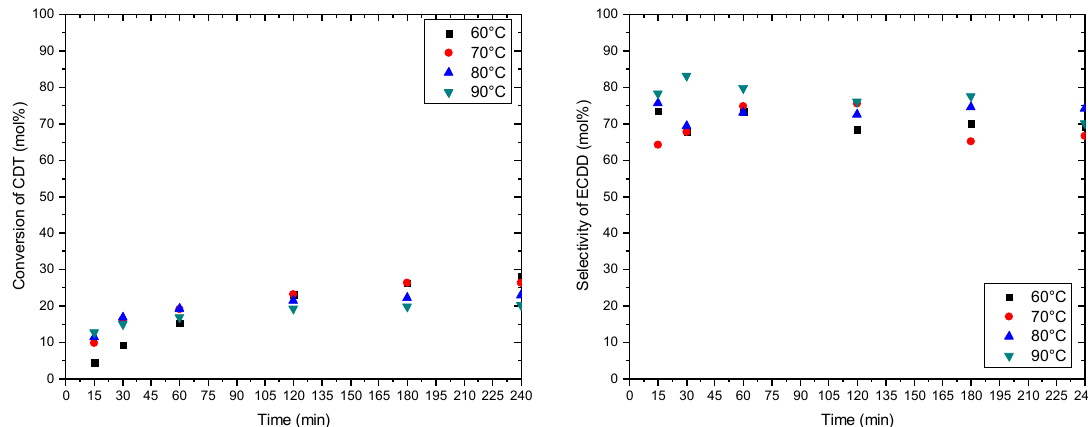
8 of 18 Figure 10. FT-IR spectrum of Ti-MCM-41 catalyst. In the FT-IR spectrum of the Ti-MCM-41 catalyst there are absorption bands at 440 and 800 cm − 1 , which correspond to deformation vibrations of the Si–O–Si groups. The band at 960 cm − 1 is related to the isomorphic substitution of Si by Ti, and it confirms the